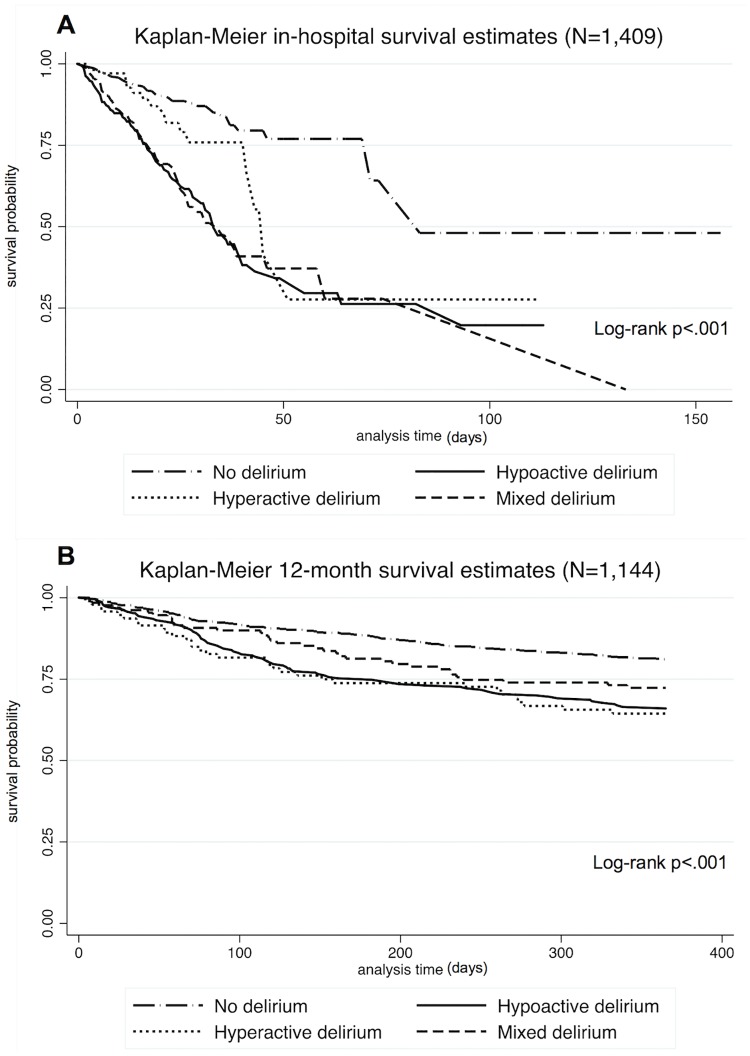
Probability of survival according to delirium motor subtypes.A. Kaplan-Meier estimates representing the probability of survival in the hospital according to delirium motor subtypes, with a corresponding log-rank test indicating a statiscally significant difference between the groups; B. Kaplan-Meier estimates representing the probability of survival in 12 months according to delirium motor subtypes, with a corresponding log-rank test indicating a statiscally significant difference between the groups.